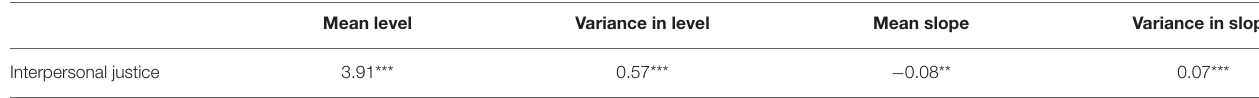
TABLE 3 | Significance tests for latent growth model